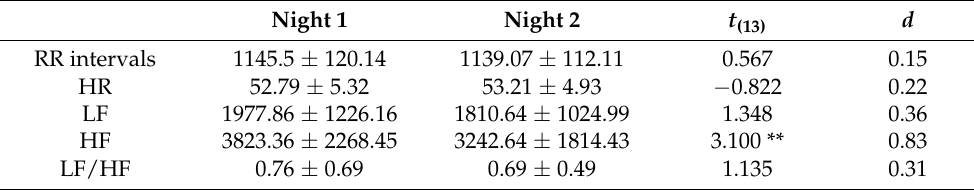
Table 4. The HRV results for stage N2 on Night 1 and Night